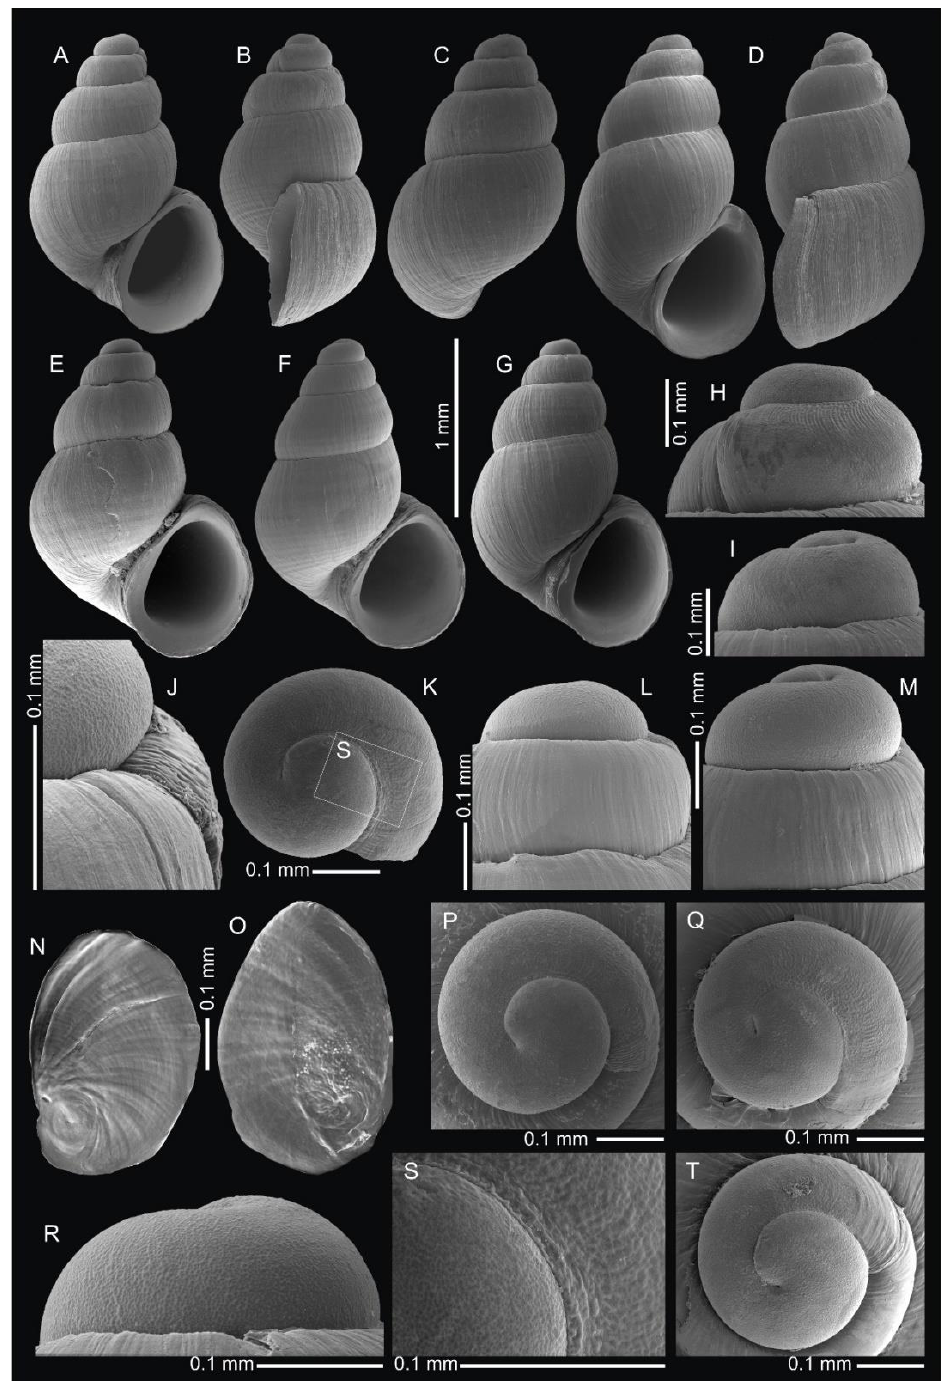
Figure 6. Clathrocaspia laevigata sp. n. shell morphology: ( A , J ) — specimen ZIN 541-2021/3_01; (( A ) — shell, (J ) — protoconch); ( B , H ) — specimen ZIN 541-2021/3_02 ((B) — shell, (H) — protoconch); ( C , I ) — specimen ZIN 541-2021/3_03 (( C ) — shell, ( I ) — protoconch); ( D ) — specimen IZAN 613/3; ( E , L , Q ) — specimen ZIN 541-2021/3_04 (( E ) — shell, ( L , Q ) — protoconch); ( F , M , T ) — specimen ZIN 541-2021/3_05 (( F ) — shell, ( M , T ) — protoconch); ( G , R ) — specimen IZAN 609/2 (( G ) — shell, ( R ) — protoconch); ( K , S ) — protoconch of specimen ZIN 541-2021/3_06 (( K ) — apical view, ( S ) — detailed view from side); ( N ) — operculum of specimen ZIN 541-2021/3_07 (from outside); ( O ) — operculum of specimen ZIN 541-2021/3_08 (from inside); ( P ) — protoconch of specimen ZIN 541-2021/3_09. D — from the locality Dag32; G, R — from the locality Dag15; all other specimens — from the locality Dag01.